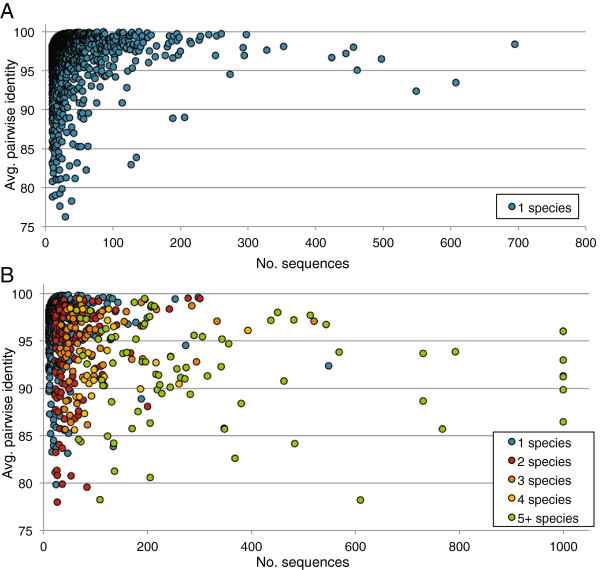
Pairwise identity of reference ITS sequences within different taxonomic groups. The plot displays average pairwise identities computed from MUSCLE alignments for groupings of ITS2 reference sequences at the (A) species and (B) genus level. The y-axis represents the average pairwise identity found between two sequences in the same species (A) or genus (B), the x-axis represents the total number of sequences from each species (A) or genus (B) that were aligned, and the color displays the total number of reference species found in each genus (B).